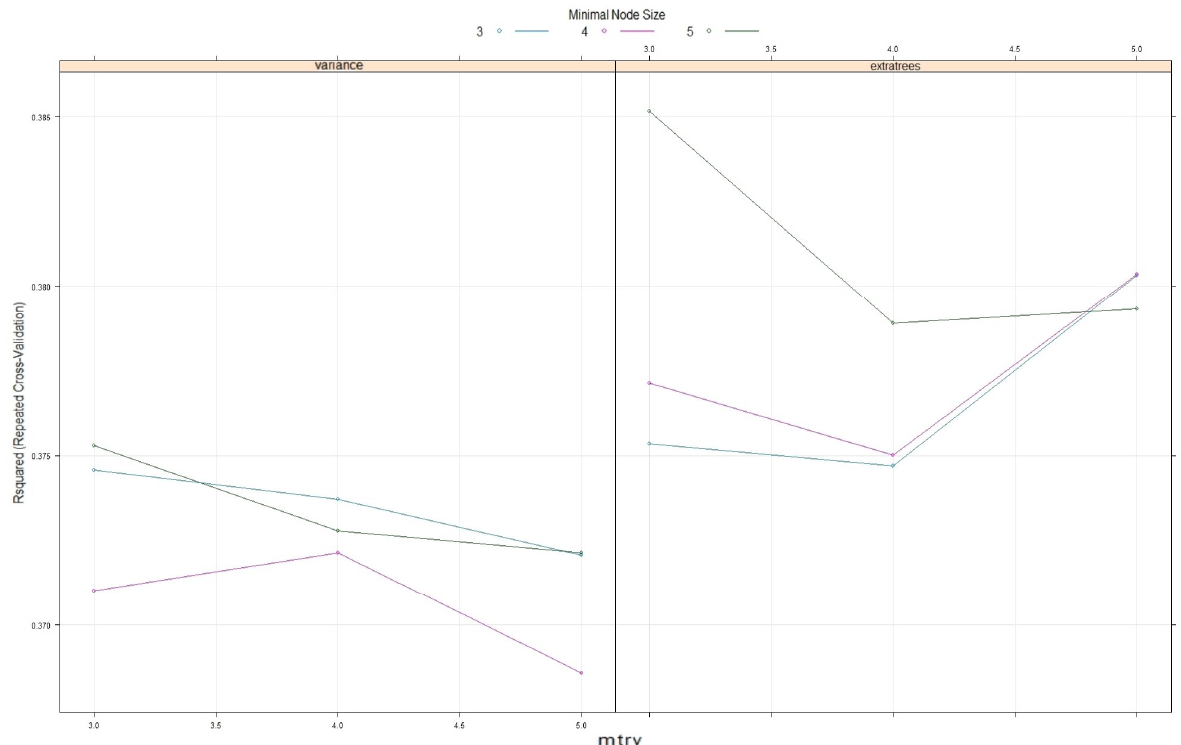
Figure 7. Hyperparameters assessment results based on R 2 in the training dataset. For the splitrule hyperparameter, only “variance”and “extratrees” methods were used due to unrecoverable errors from “maxstat” and “beta” values. Table 5. Hyperparameters’ range and values used in the current study for RF and QRF. Parameter Range Value Used mtry 3–5 3 num.trees 500, 1000 500